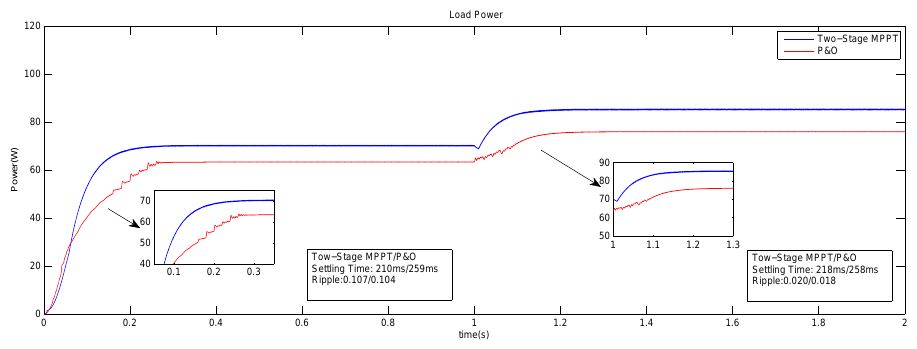
Figure 10. Load power under temperature changes.